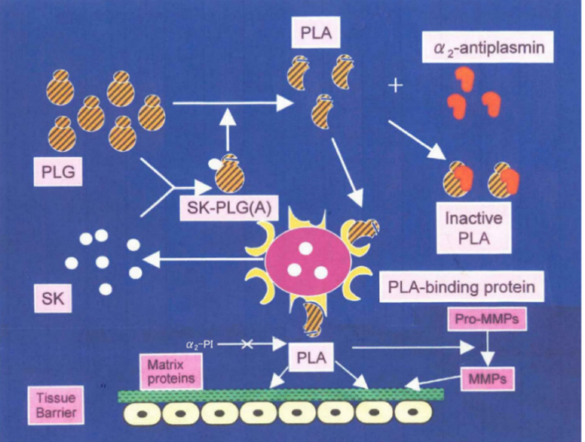
Figure 8. Reported mechanism for the tissue invasion of Streptococcus through direct binding pathway dependent on streptokinase and plasminogen. PLG: plasminogen, PLA: plasmin, SK: streptokinase, MMPs: matrix metalloproteases.